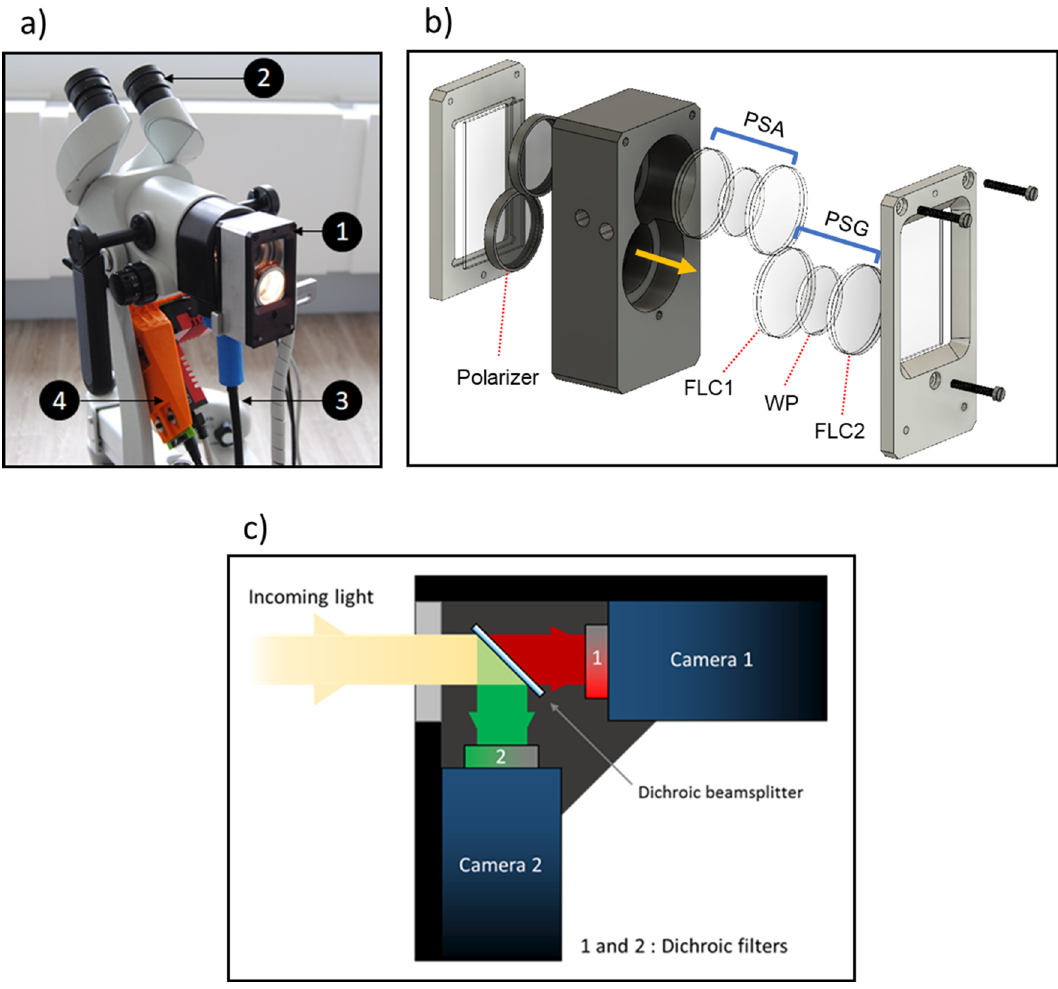
Figure 6. ( a ) Photo of the entire MPC (1: Mueller polarimeter, 2: binocular system for stereoscopic vision of the cervix, 3: liquid light guide, 4: dual-camera system). ( b ) Sketch of the polarimetric box and detailed description of PSG and PSA (image created with SOLIDWORKS Premium 2021 SP4.1, URL: http:// www. 3ds. com/ terms/ ost). The orange arrow indicates the direction of light propagation. ( c ) Incoming light from the optical output of